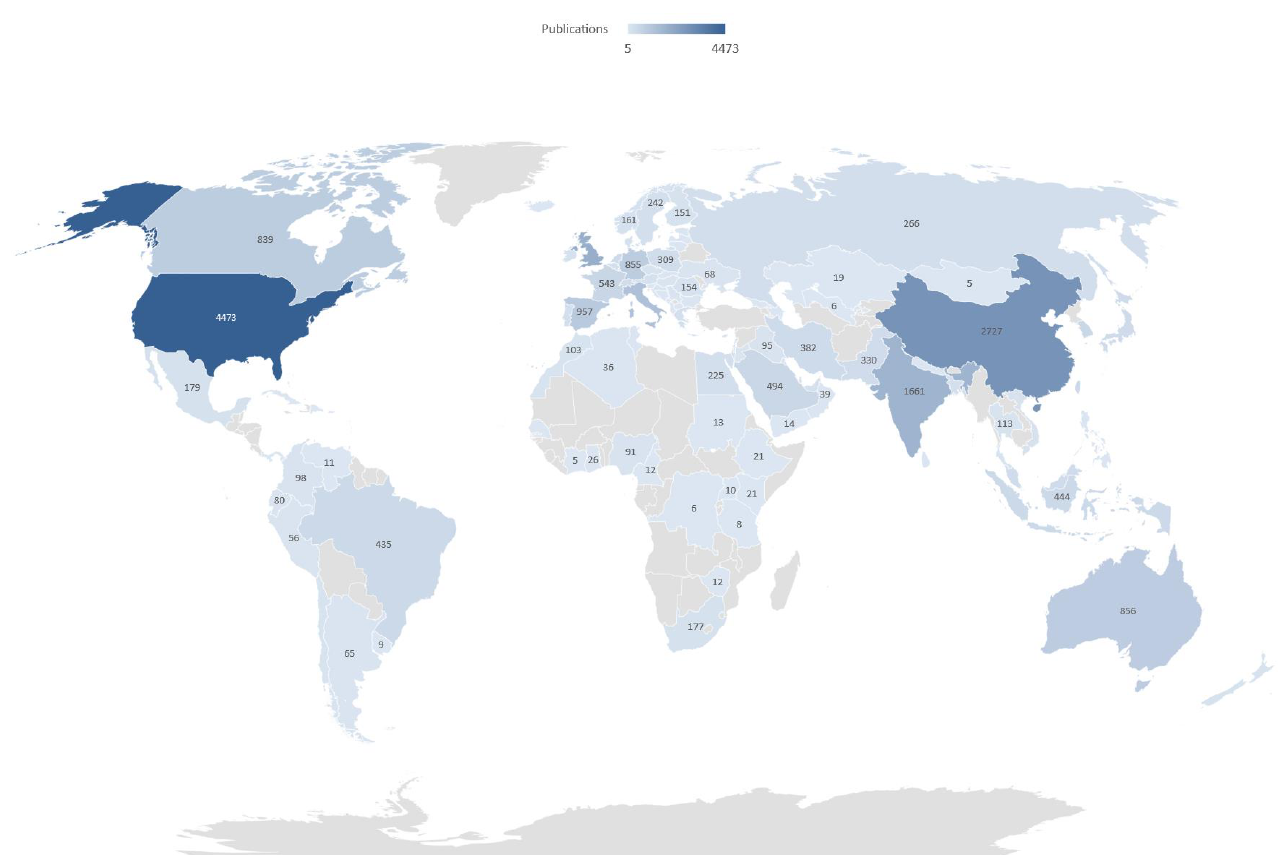
Figure 2. Number of COVID-19 and emerging technologies publications by country (source Scopus).